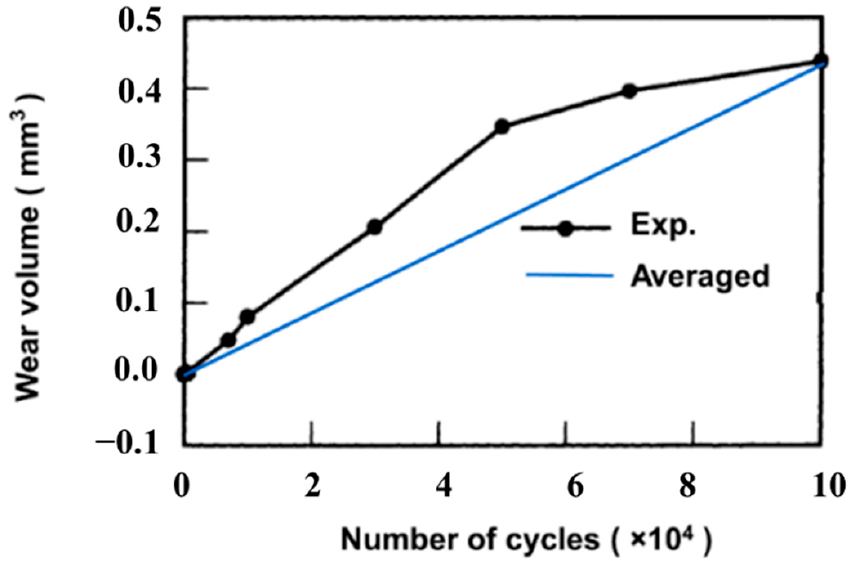
Figure 1. Experimental variation of wear volume with the number of cycles vs. assumed variation of wear volume in finite element (FE) model for different loading cases.